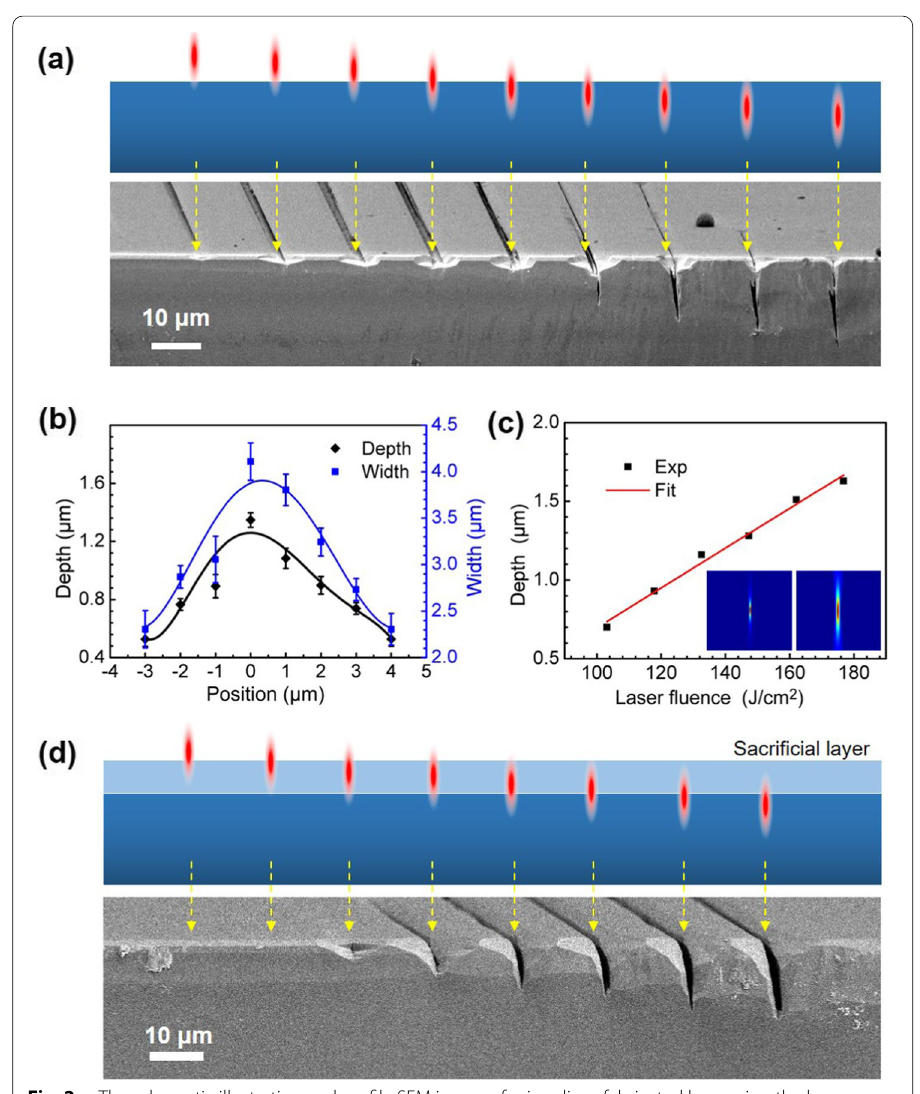
Fig. 2 a The schematic illustration and profile SEM image of micro‑lines fabricated by varying the laser focus at different relative positions (without the sacrificial layer, after HF etching). b The relationship of the depth/width of the resultant micro‑lines and the relative position of laser focus to the sapphire surface. c The dependence of the depth of undamaged regions on the laser fluence. The insets are intensity distribution of laser focus with low (left) and high (right) fluence. d The schematic illustration and profile SEM image of micro‑lines fabricated by varying the laser focus at different relative positions in the presence of a sacrificial layer (after HF